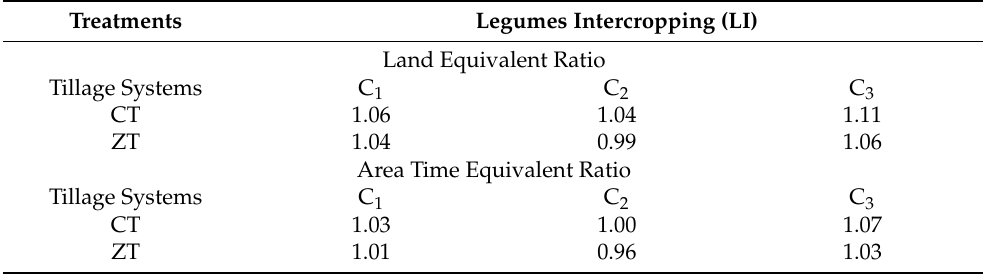
Table 3. Effect of different tillage systems and legume intercrops on land equivalent ratio and area time equivalent ratio of system productivity.